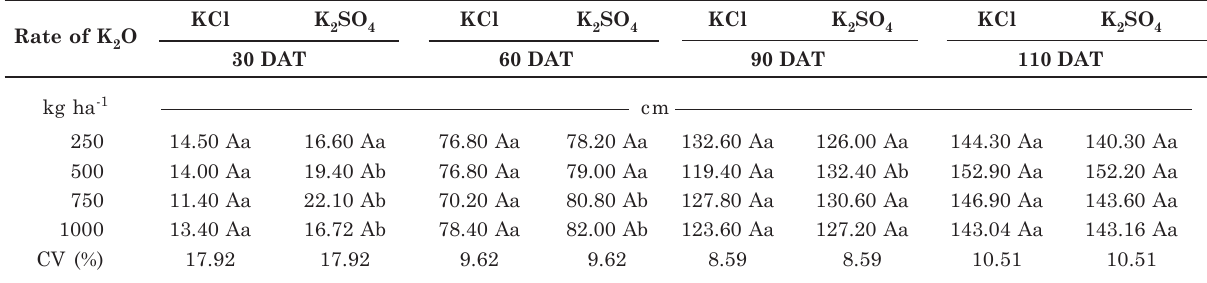
Same capital letters in the column and same lowercase letters in the row do not differ from each other at the 5 % by the Scott-Knott